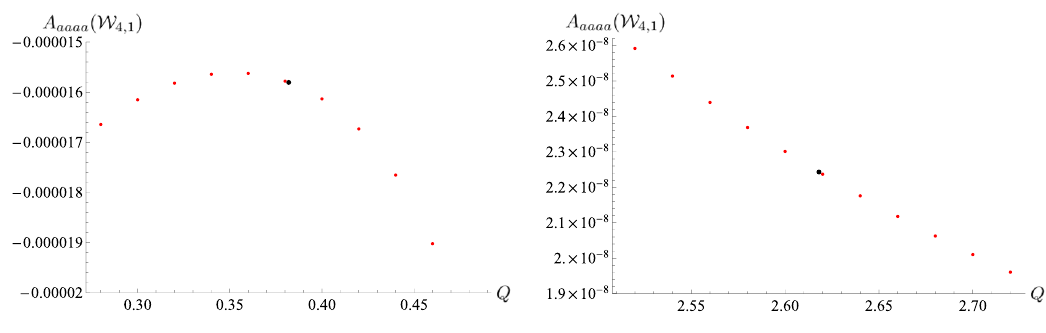
(cid:0) 2 π (cid:1) (left) and 5